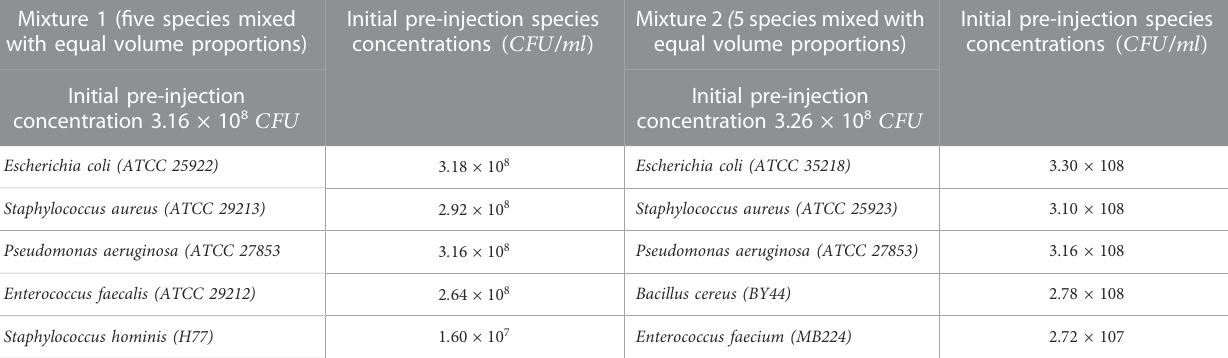
TABLE 4 Trial details highlighting the two mixtures of bacteria, their composition, pre-injection concentrations, for each of the two trial runs of 20 min durations each. The relative start and stop times of sample injection during trial runs with mixtures, are 10 sec and 1140 sec respectively. Mixture 1 ( fi ve species